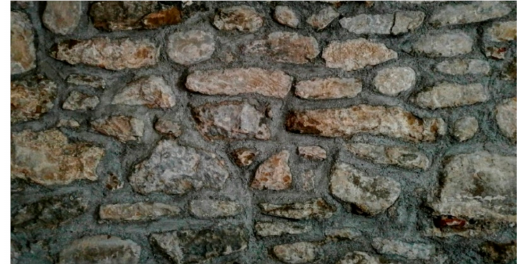
Figure 3. Texture of the masonry.